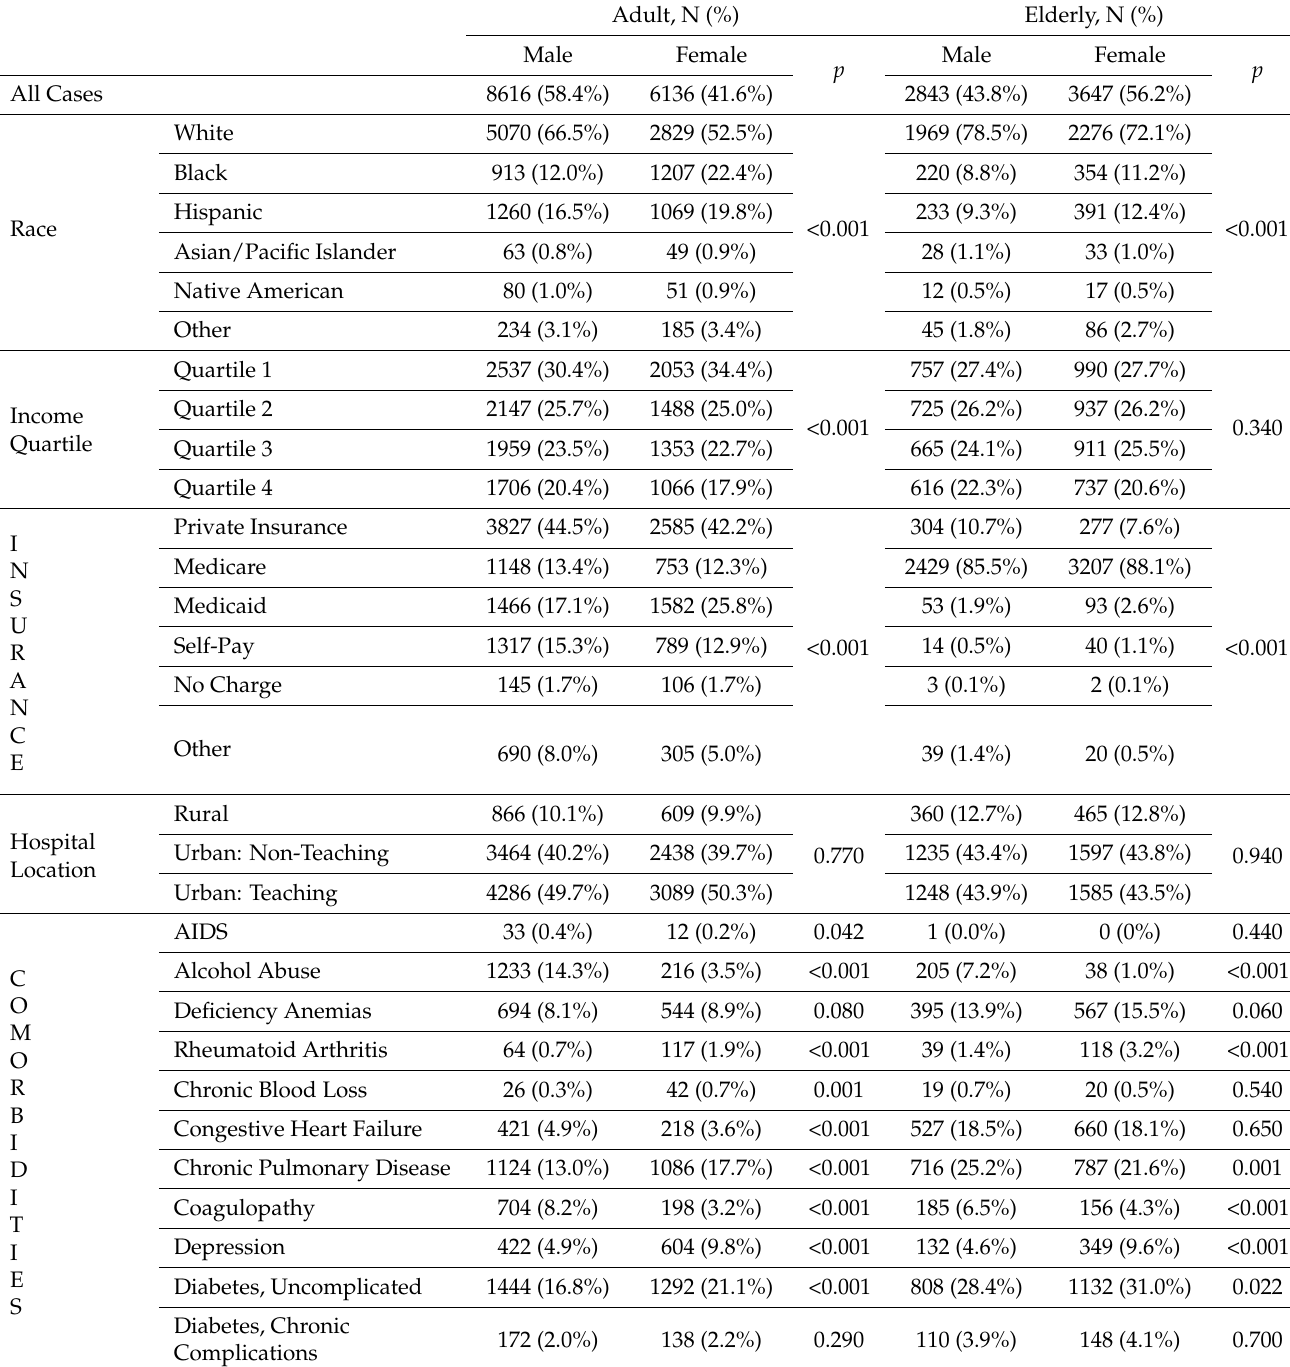
Table 2. Emergently admitted patients with the primary diagnosis of umbilical hernia, presented and stratified based on sex categories (NIS 2005–2014). Adult, N (%) Elderly, N